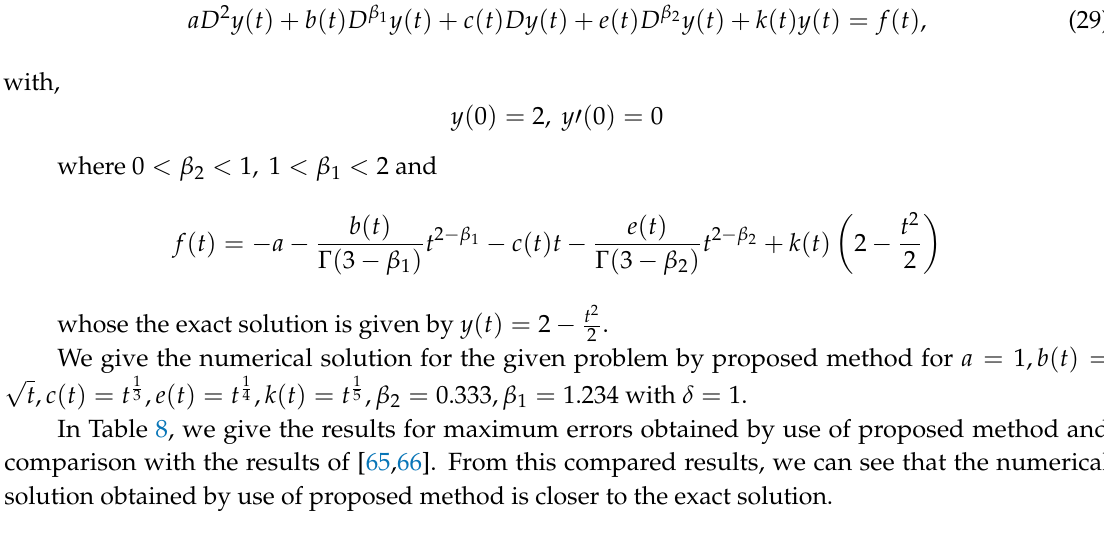
Table 8. Maximum errors of Example 5 for R = 1 with m = 3,4,5,6,10,20,40. m Present Method Method Given in